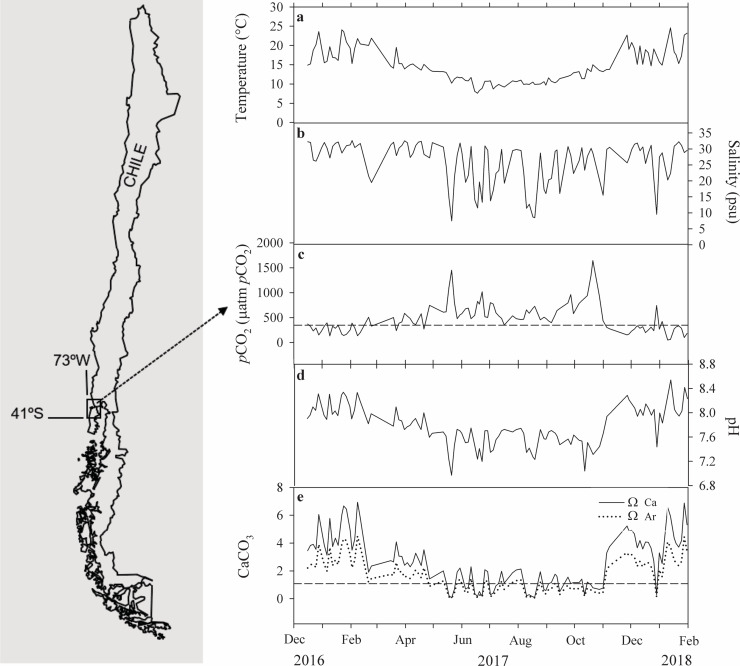
Annual variation of environmental parameters at the Quempillén estuary, Southern Chile.Time series of temperature (a), salinity (b), pCO2 (c), pH (d) and ΩCaCO3 (e). Map taken from Lagos et al. (2016).